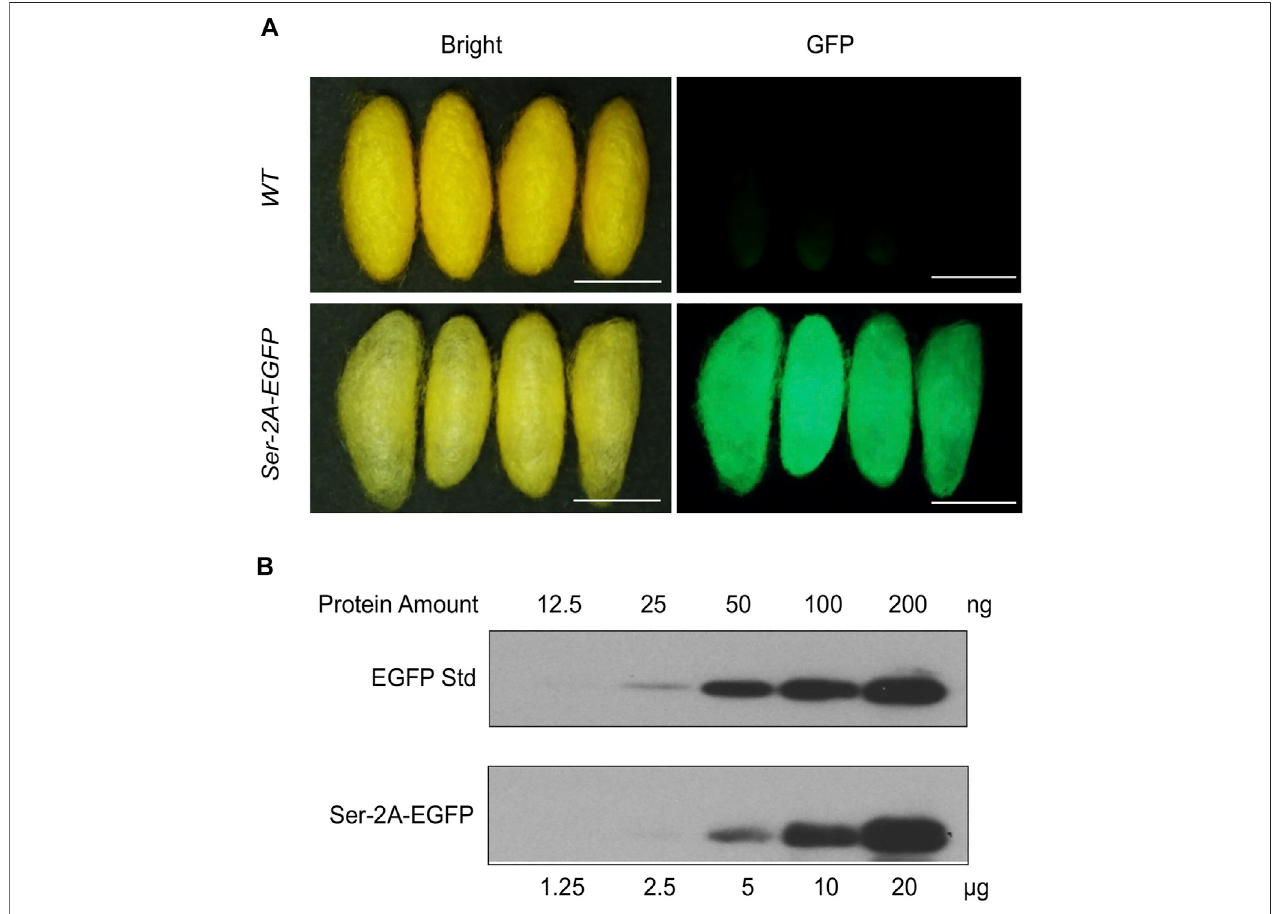
FIGURE5| Quanti fi cationofEGFPproteinin Ser – 2A – EGFP cocoonshells. (A) Fluorescenceobservationof Ser – 2A – EGFP cocoonshells.Theupperrowisthe WT cocoon shells, and the lower row is the Ser – 2A – EGFP cocoon shells. Both bright and GFP fi eld are shown. Scale bars stand for 1 cm. (B) Quanti fi cation of the EGFP protein in the Ser – 2A – EGFP cocoon shells. Proteins were diluted in a twofold series dilution manner and sent for analysis. The maximum amount for crude silk proteins and EGFP standard were 120 μ g and 200 ng, respectively.